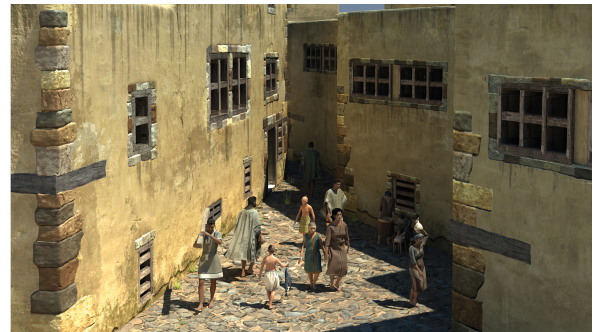
Figure 11: Virtually reconstructed 3D artist impression of Tri- angle square with the Westhouse to the left. The human figures were requested by National Geographic for a popular magazine publication.